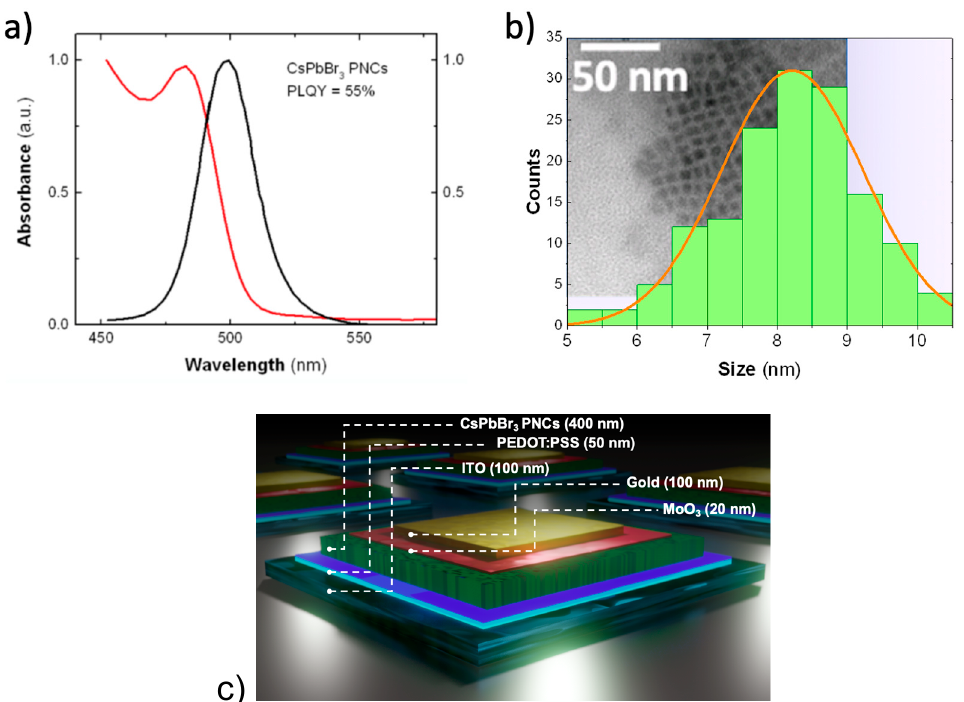
Figure 1. ( a ) UV-visible and PL spectrum of synthesized CsPbBr 3 perovskite nanocrystals (PNCs); ( b ) size distribution of CsPbBr 3 PNCs as extracted from TEM images as the one shown in the inset; ( c ) schematic representation of the device architecture.